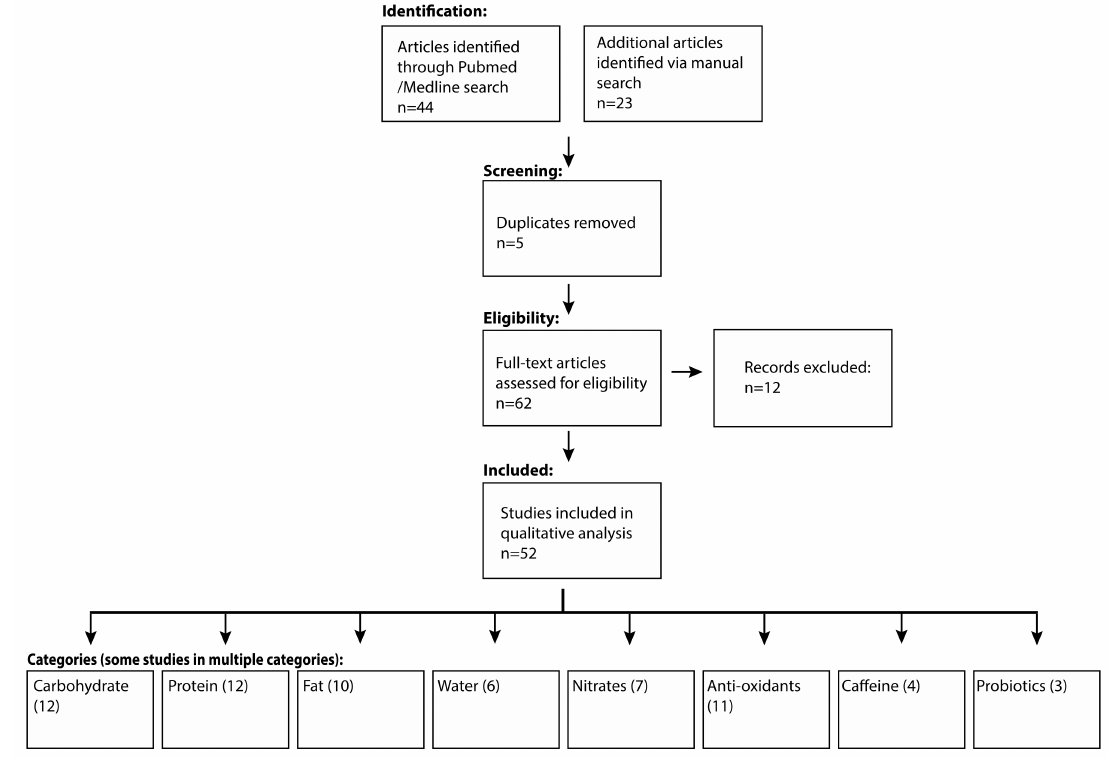
Figure 1. PRISMA flow diagram search